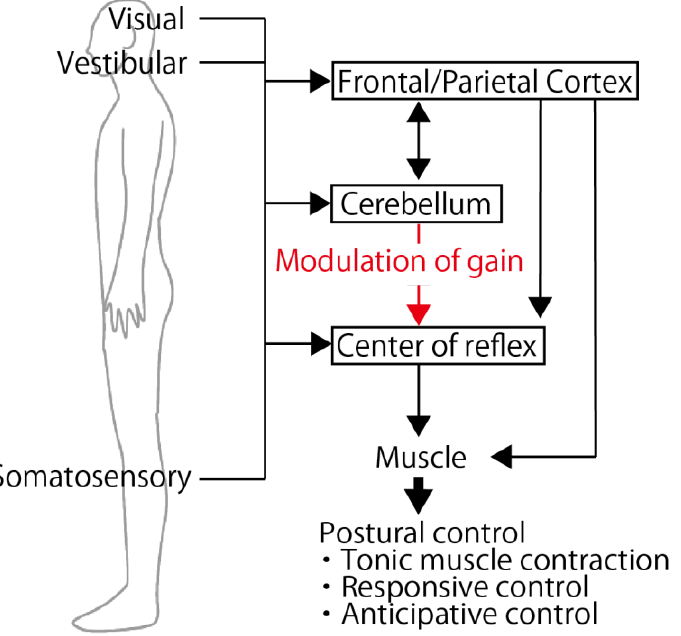
Figure 1. Brief schematic summary of the role of the cerebellum in postural control. The cerebellum modulates the gain in the spinal reflex and the excitability of the motoneuron pool. In particular, responsive postural control and muscle tones are under cerebellar control.